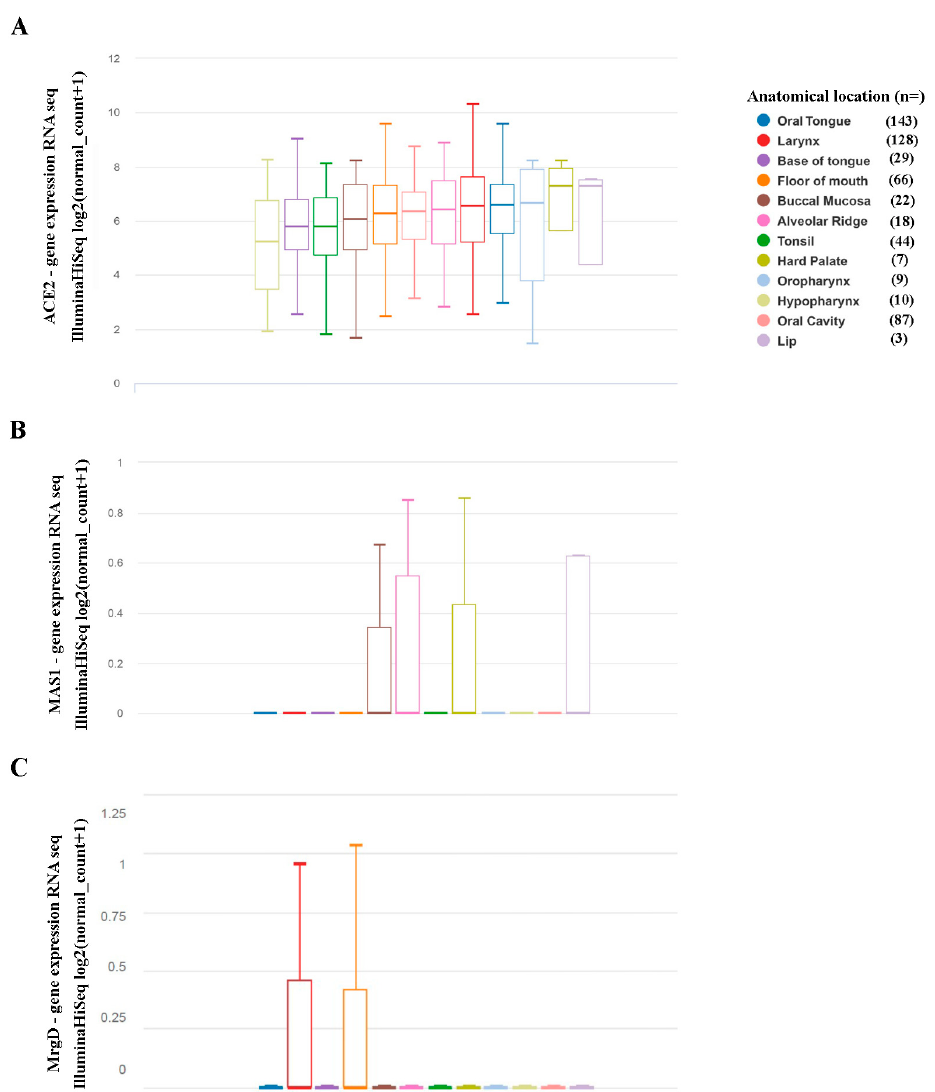
Figure 2. Levels of gene expression of members of the beneficial arm of the renin-angiotensin system in head and neck squamous cell carcinoma (HNSCC). Data from the TCGA HNSCC study (21 datasets, n = 604 samples, hence 566 with mRNA analyses) were used to investigate the expression of ACE2 ( A ), Mas ( B ), and MrgD ( C ), along with distinct anatomic locations of HNSCC. Analyses were performed using the UCSC Xena browser.